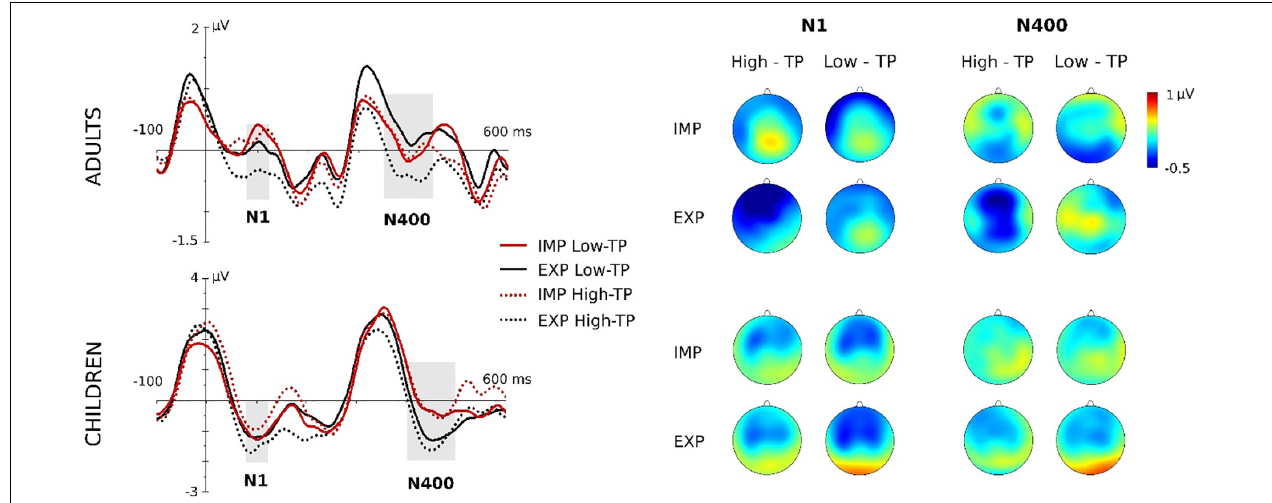
FIGURE 2 | Grand-averaged waveforms (central ROI) and topographic maps for adults and children. “IMP” stands for the aSL task performed under implicit conditions, whereas “EXP” for the aSL performed under explicit instructions (first and second blocks collapsed). Gray-shaded rectangles indicate the analyzed time windows. For a better visualization of the effects, data depicted in this figure were low-pass filtered at 25 Hz after grand average.